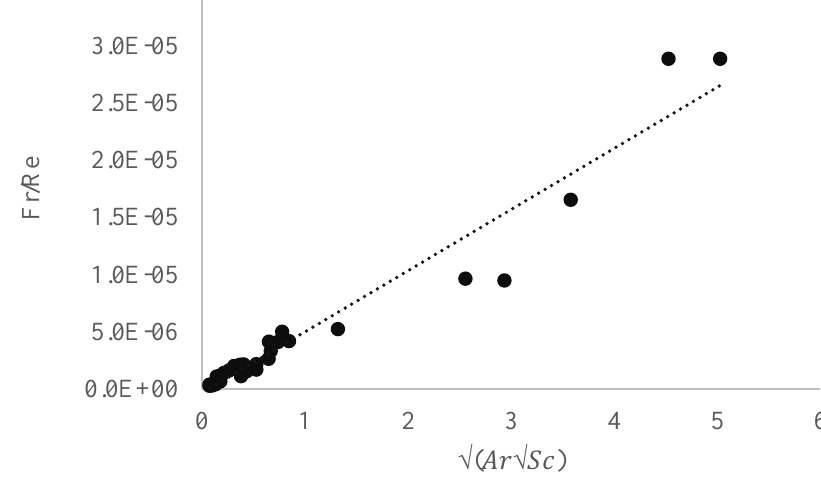
Figure 2—Plots of Fr/Re against √𝑨𝒓√𝑺𝒄 in sandpacks from the compilation by Nenninger and Dunn (2008). Specific gravity of heavy oil is taken to be 0.9.